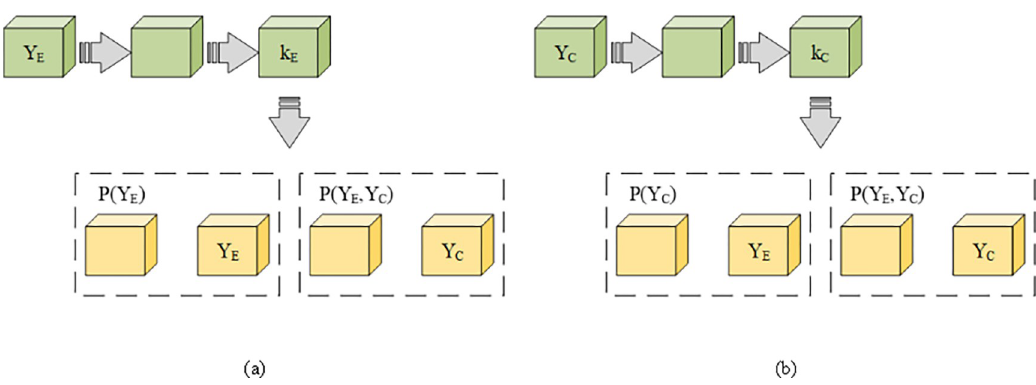
Fig 4. Learning diagram. a: SL A vector reconstruction; b: TL B vector